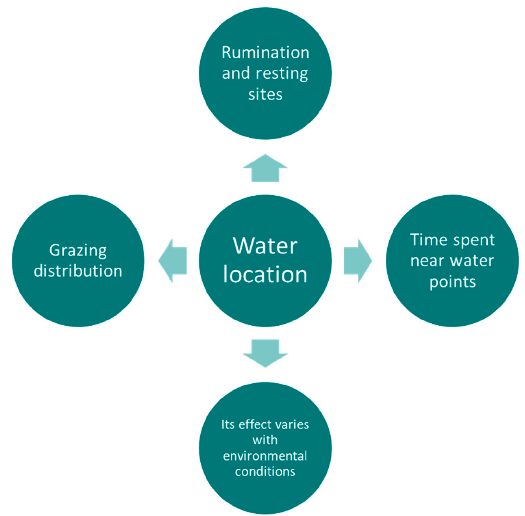
Figure 7. Summary diagram of the main variables of site use preference being affected by the location of water